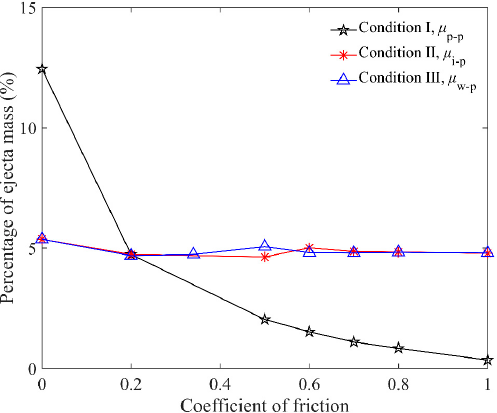
( b ) Figure 12. Kinetic energy of particles in the cup 𝐸 (cid:2921)(cid:2913) in three regions versus time for granular bed with L p = 4 mm, 6 mm, 8 mm, 10 mm elongated particles: ( a ) is for the glass impactor, and ( b ) is for the brass impactor. 4.2. Effect of Friction Coefficient To evaluate the influence of particle friction on penetration, the friction coefficients of the target particles ( μ p-p ), impactor and particles ( μ i-p ), and cup wall and particles ( μ w-p )